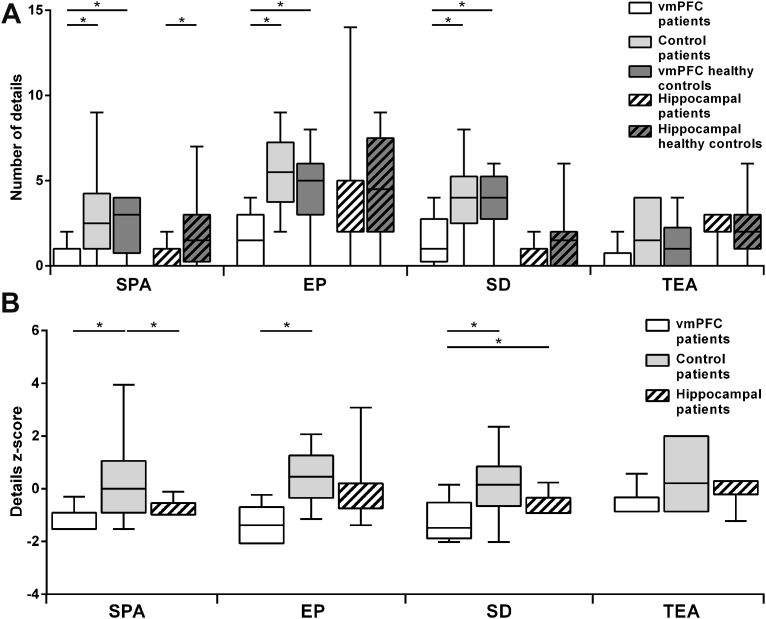
A: Box-plots of the number of constructed details in the scene probe task, with SPA = spatial references; EP = entities present, SD = sensory descriptions; TEA = thoughts/emotions/actions. The data and significance levels contrasting patients with hippocampal damage and their controls are from Mullally et al. (2012). B: Box-plots of z-scores for details produced in the scene probe task for the three patient groups. Boxplots depict the median, first and third quartiles, and minimum and maximum (whiskers) of the data sets. *p < .05.